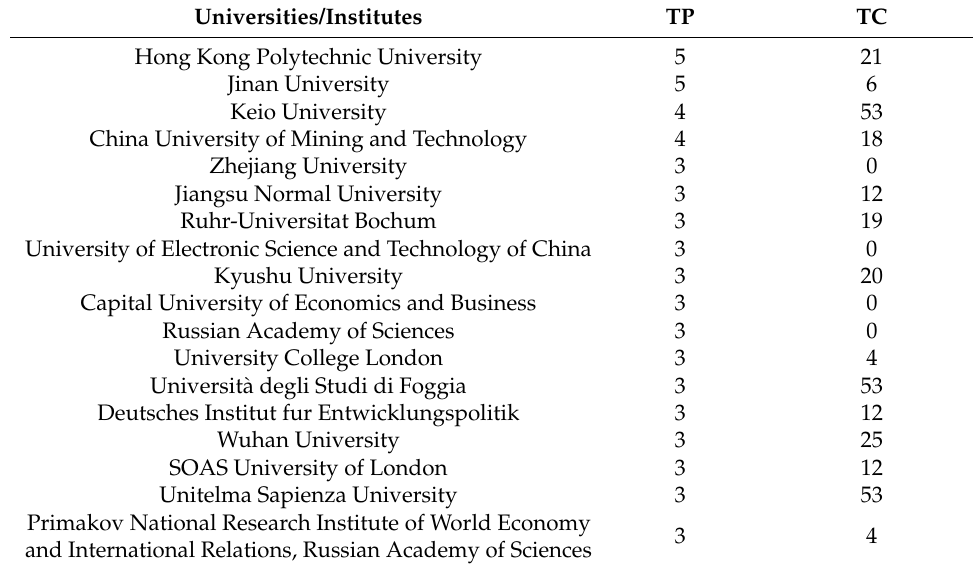
Table 3. The most productive universities (line 196).